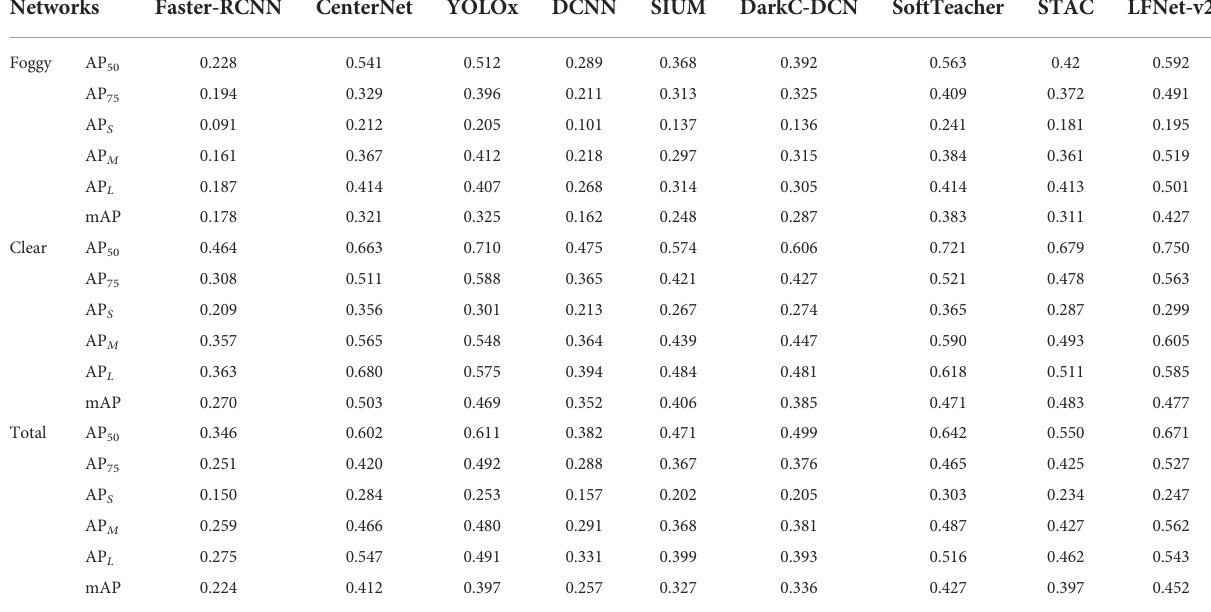
TABLE 3 Comparison of the proposed method with eight state-of-the-art object detection methods. Networks